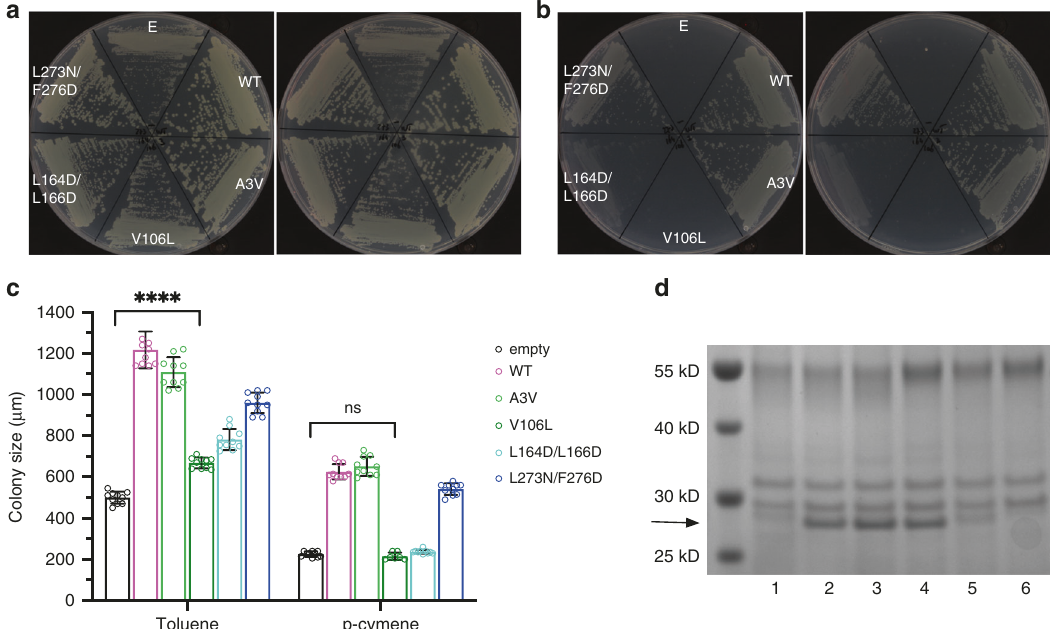
Fig. 8 Structure-function studies of CymD. a , b Growth on toluene ( a ) and p-cymene ( b ) for Pp F1-3 complemented with pHERD30-expressed cymD variants. Growths shown are representative of 2 or 3 plates. c Quantitation of growth via measurement of maximum colony sizes from ( a ) and ( b ) (mean ± S.D; n = 6 – 10). Signi fi cance levels were analysed via two-tailed Student ’ s t test. n.s., not signi fi cant ( p = 0.2); ****, p < 0.000001. d SDS-PAGE showing OM expression levels of the various strains. The location of CymD is shown by the arrow. Only boiled samples are shown. Source data for colony sizes are provided in the Source Data fi